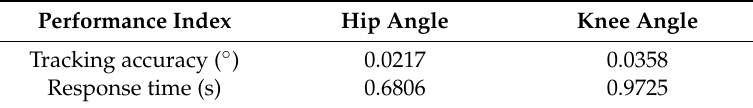
Table 2. Mean of tracking accuracy and response time of APAL.